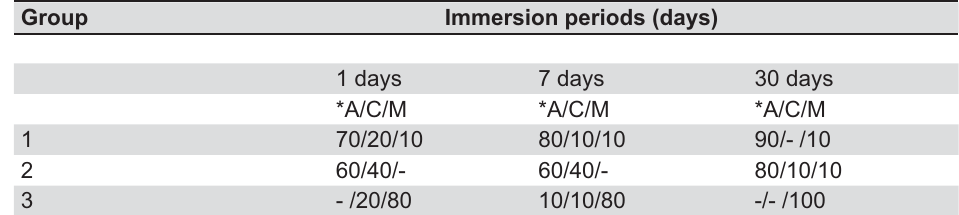
*A=adhesive; C=cohesive; M=mixed modes of